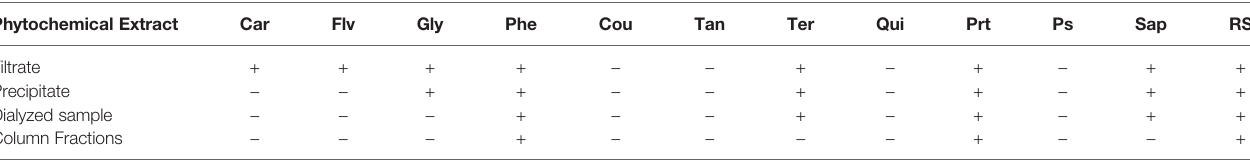
TABLE 1 | Phytochemical testing of different extracts of plant Carissa carandas . Phytochemical